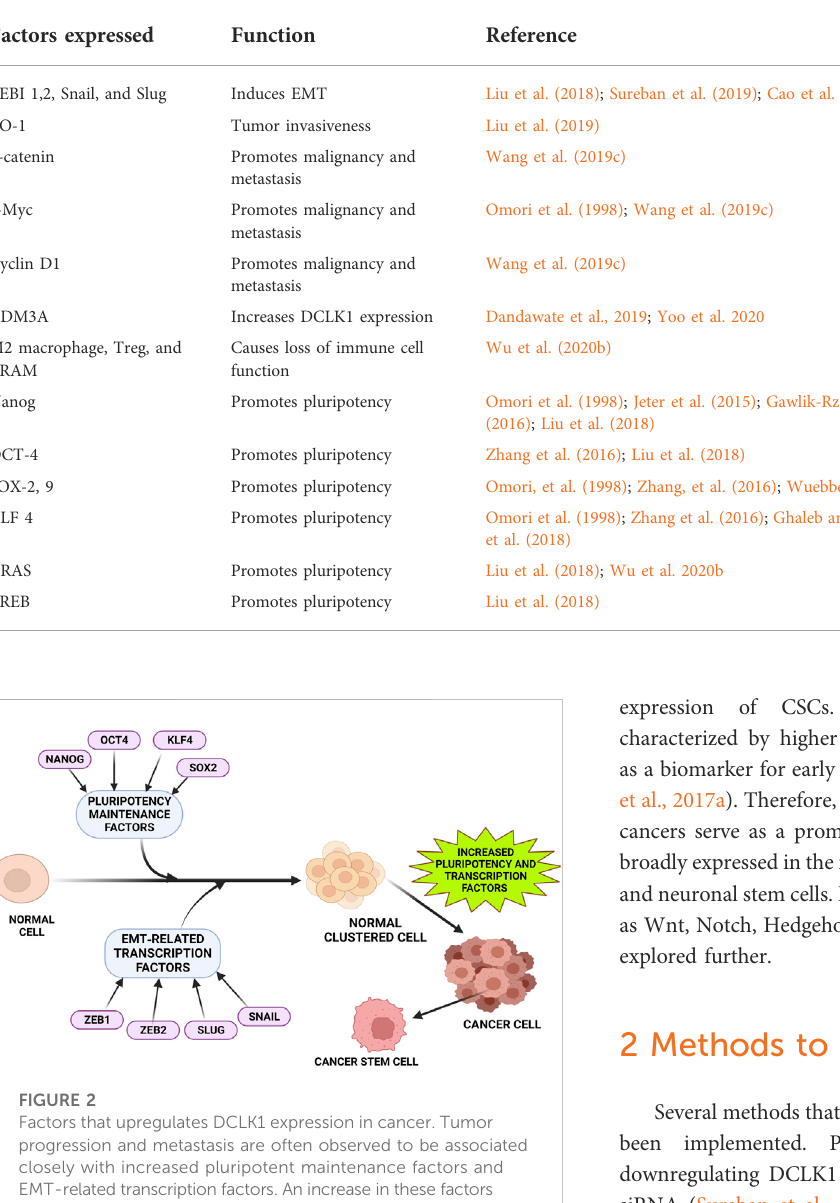
TABLE 1 Factors expressed by cancer cells that upregulates DCLK1 expression.